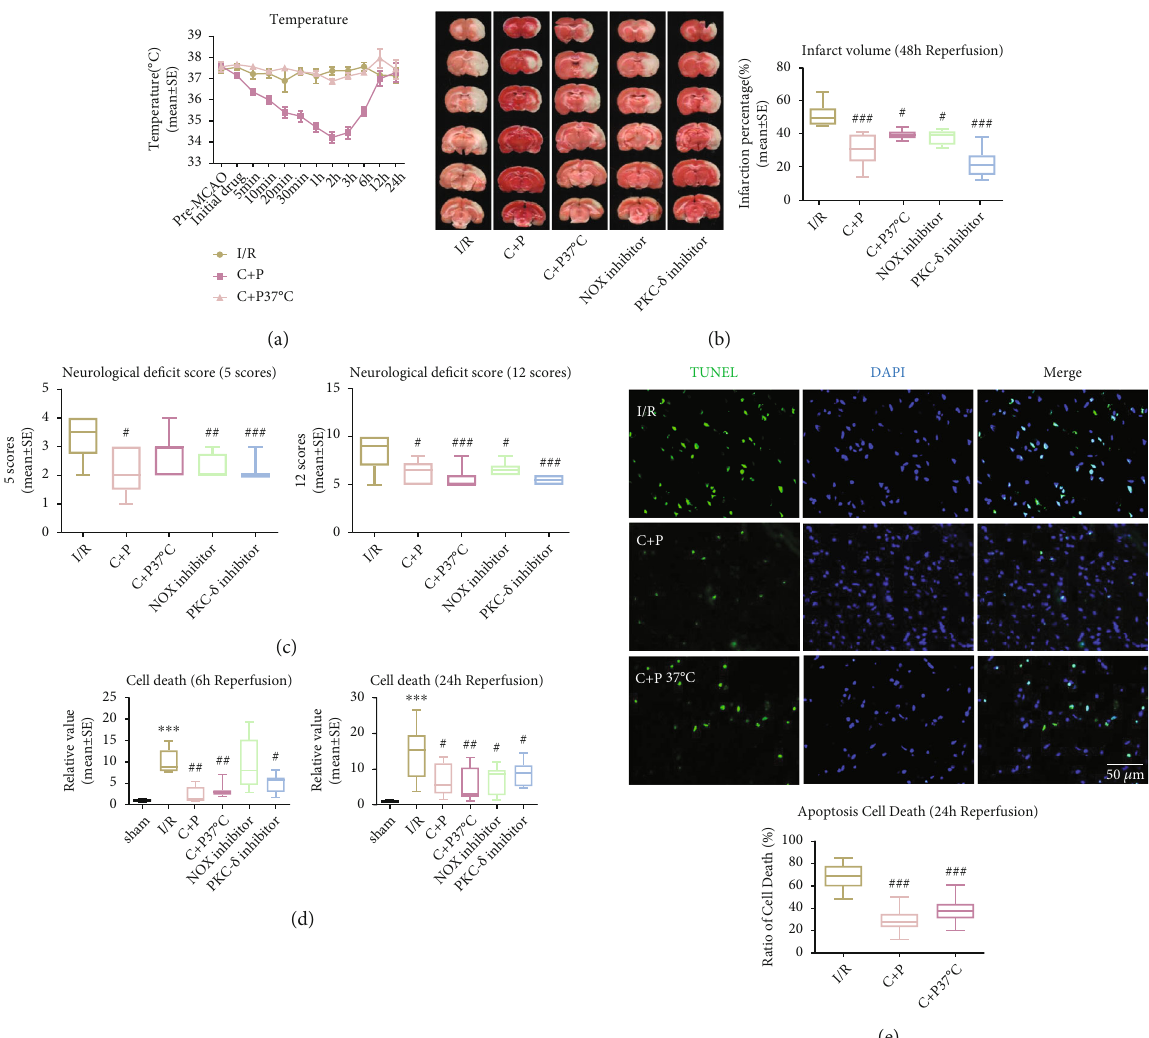
Figure 1: C+P lessened postischemic neurologic damage. (a) Alterations in body temperature post C+P administration at various points in time in 2-hour MCAO and after reperfusion (0 – 24 hours). Baseline temperatures were determined just before MCAO. Reperfusion was followed by C+P administration. ANOVA analyses speci fi ed that C+P signi fi cantly decreased body temperatures as early as 5 minutes and lasting up to 6 hours after the I/R onset ( n = 7 ). (b) TTC stains showcase infarction volumes in MCAO rats regardless of C+P treatment at 48 hours of reperfusion. C+P administration or administration of the PKC- δ /NOX inhibitor signi fi cantly decreased infarct volumes ( n = 7 ). (c) Neurologic de fi cits were determined using 5- or 12-point scoring systems at 48 hours of reperfusion. C+P administration or the administration of the PKC- δ /NOX inhibitor signi fi cantly reduced neurological de fi cits in all groups except those in the temperature-controlled C+P group, for which there was no e ff ect on the 5-point scoring system ( n = 7 ). (d) Cell death was signi fi cantly higher at 6 and 24 hours of reperfusion, demonstrated by ELISA. With C+P at 6 and 24 hours of reperfusion, cell death was signi fi cantly reduced. Administration of the PKC- δ /NOX inhibitor also suppressed cell death except in the NOX inhibitor group at 6 hours of reperfusion ( n = 7 ). (e) Apoptotic cell death was signi fi cantly reduced with C+P administration regardless of temperature control at 24 hours of reperfusion, shown using the TUNEL assay ( n = 5 ). Scale bar = 50 μ m . ∗∗∗ p < 0 : 001 versus the sham group; # p < 0 : 05 , ## p < 0 : 01 , and ### p < 0 : 001 versus the I/R group. Results are shown as mean ± SE